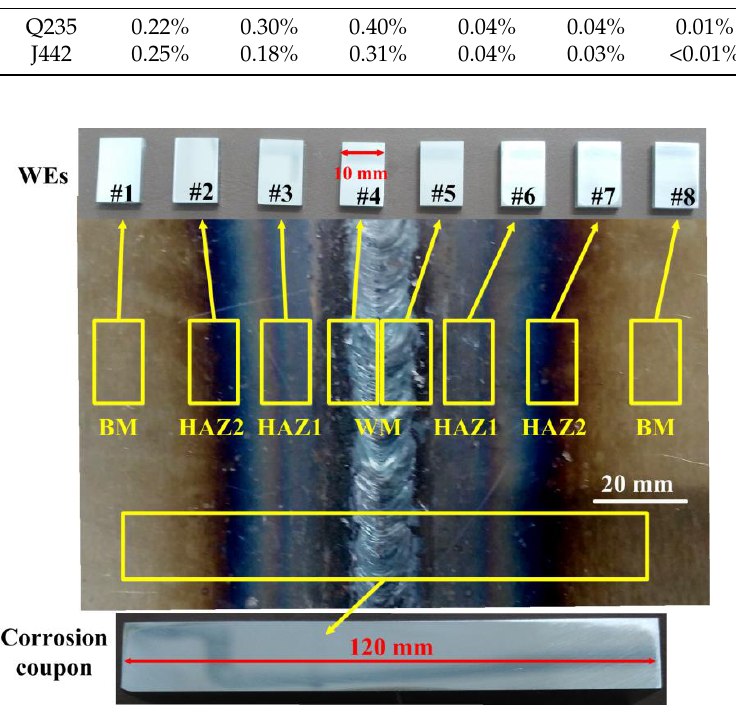
Table 1. Chemical components of Q235 steel plate and J442 welding rod. C Si Mn P S Cr Ni Fe C Si